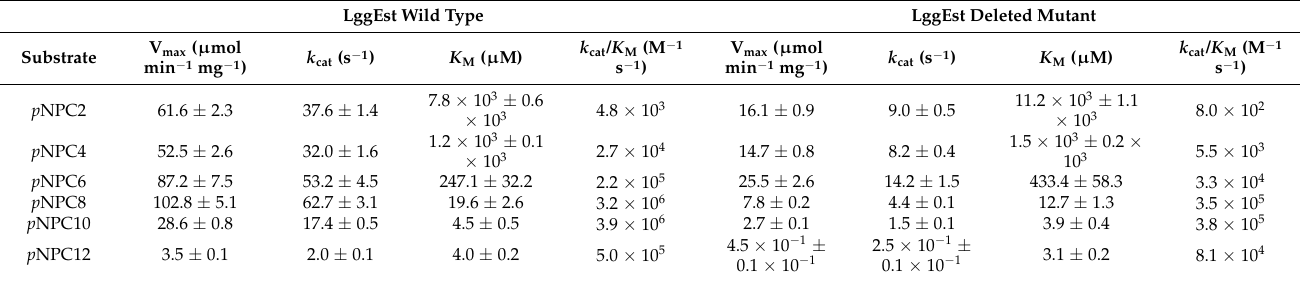
Table 1. Michaelis-Menten kinetic parameters of recombinant LggEst wild type and the deleted